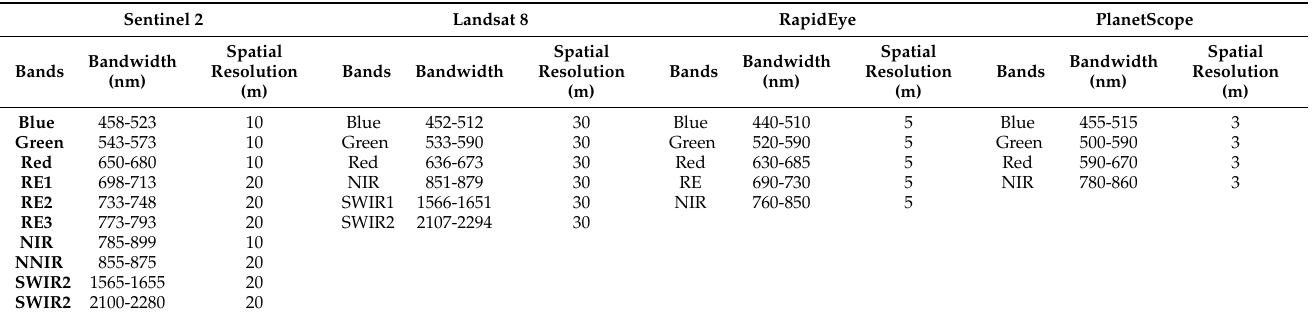
Table 1. Details of the spectral and spatial resolution of satellite